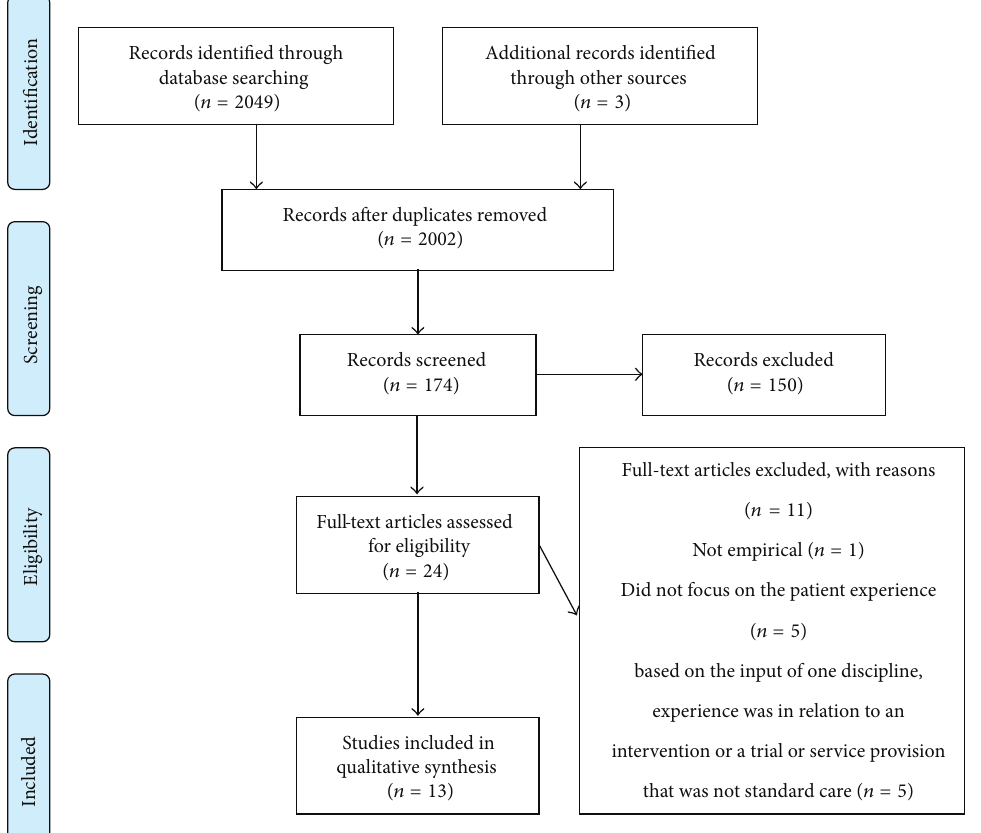
Figure 1: A PRISMA diagram for the study. This is based on PRISMA 2009 flow diagram and shows the search results across all four databases with numbers of articles retrieved and excluded at each stage of the selection process[14]. For more information, visit